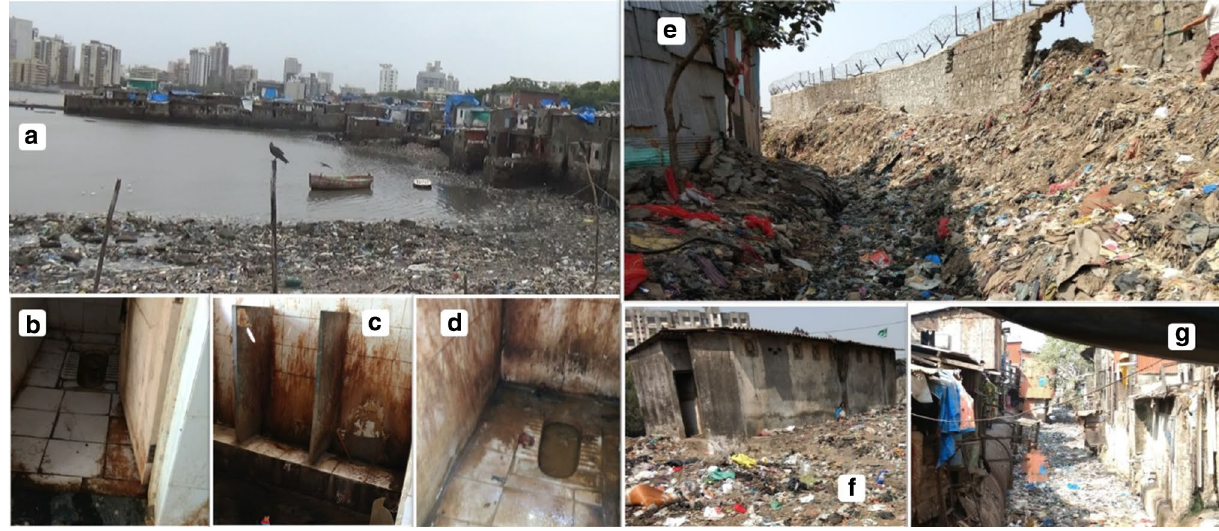
Fig. 3 a Seaside view of Machimar Colony at Colaba, b a good-con- ditioned toilet seat at Baiganwadi, c a poor condition urinal at Shiva- jinagar, d a stool overflowed toilet seat at Shivajinagar, e the leachate drain and the waste beside Deonar dumping ground wall with a